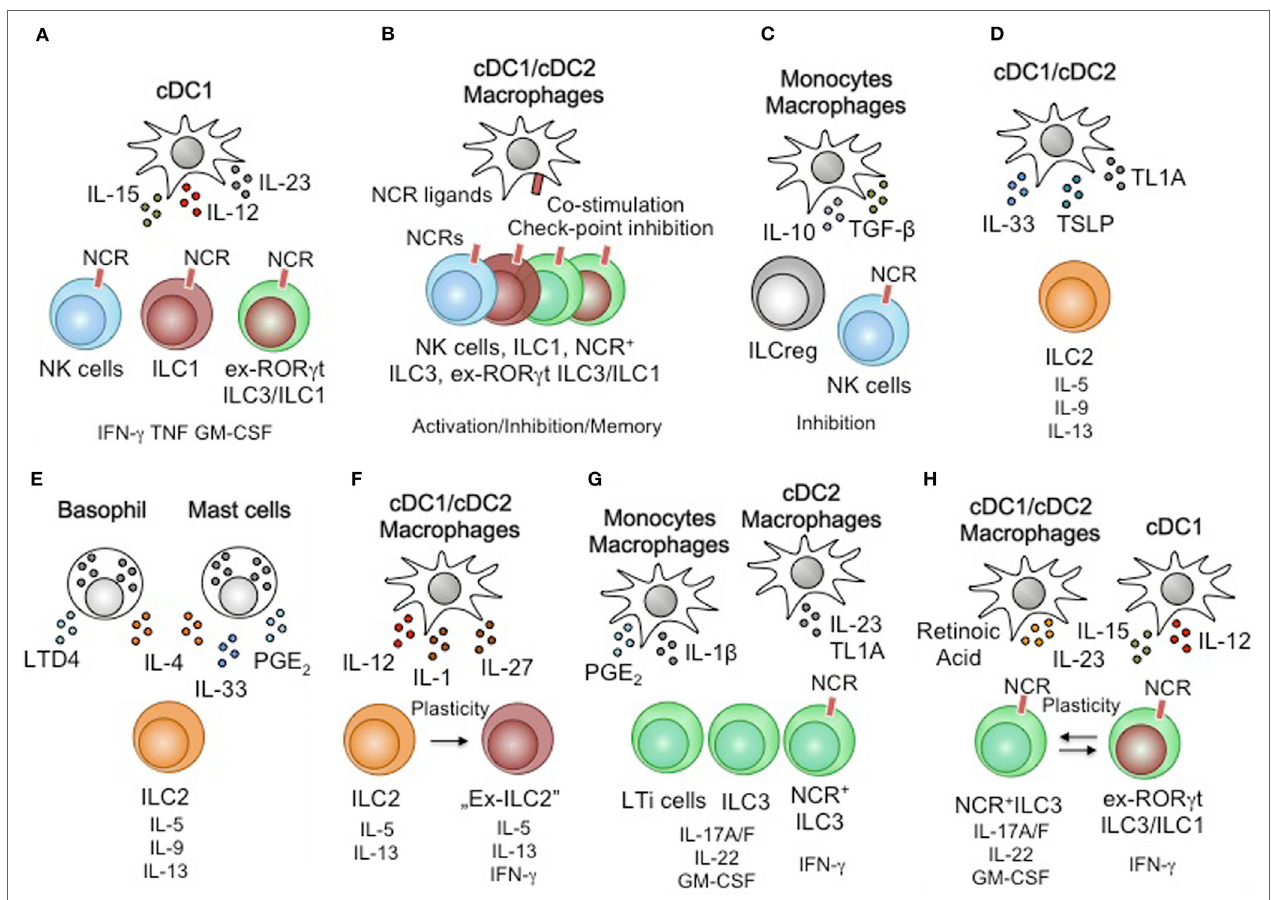
FiGURe 2 | Myeloid regulation of innate lymphoid cells (ILCs) function and plasticity. (A) Dendritic cells (DCs) activate natural killer (NK) cells, group 1 ILCs (ILC1), ex-ILC3/ILC1 through interleukin (IL)-12, IL-15, and IL-23. (B) Natural cytotoxicity receptor (NCR)-expressing ILC subsets are subject to receptor-ligand mediated activation or inhibition. Improved immune responses through re-occurring engagement of activating receptors have been associated with memory-like behavior in NK cells. Co-stimulatory receptors and checkpoint inhibitory ligands could control the interactions of macrophages/DCs and ILCs. (C) Monocyte/macrophages inhibit NK cells via IL-10 and TGF- β secretion. (D) DC subsets are capable of activating ILC2 through the production of IL-33, thymic stromal lymphopoietin (TSLP), and TL1A. (e) PMN leukocytes (basophils and mast cells) activate ILC2 through IL-33, IL-4, and lipid mediators. (F) DC subsets and macrophages influence the stability of ILC2 by inducing type 1 immune features through IL-12, IL-1, and IL-27 leading to plastic behavior of ILC2. (G) ILC3 are activated by monocyte/macrophages and DCs. Lipid mediators and the cytokines IL-1 β , IL-23, and TL1A drive ILC3 effector functions. (H) Retinoic acid, IL-23, IL-15, and IL-12 are myeloid-derived cytokines that control the plasticity and transition of NCR + ILC3 and ex-ROR γ